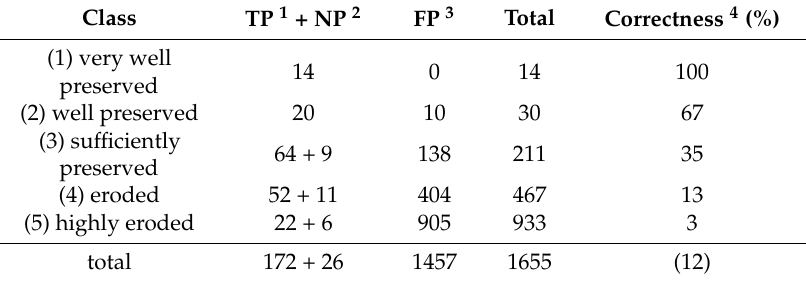
Table 8. Results of the classification of Burial Mounds in the investigation area in Table 8 . Results of the classification of Burial Mounds in the investigation area in Haltern.